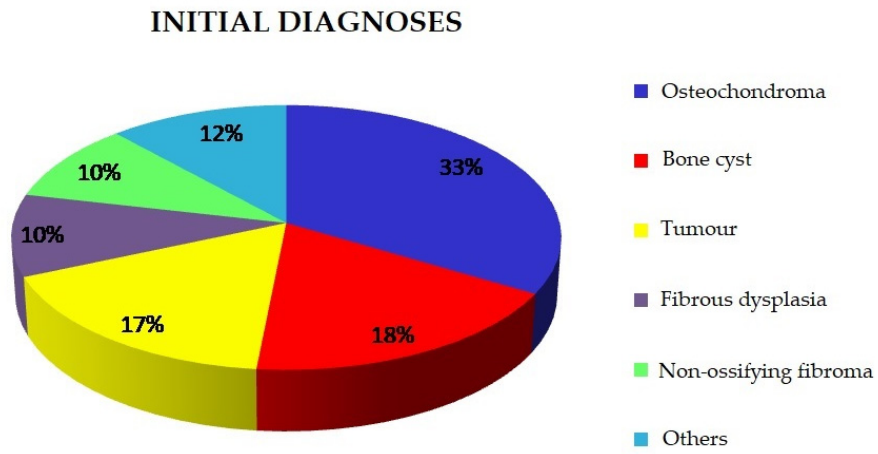
Figure 1. Initial diagnoses.